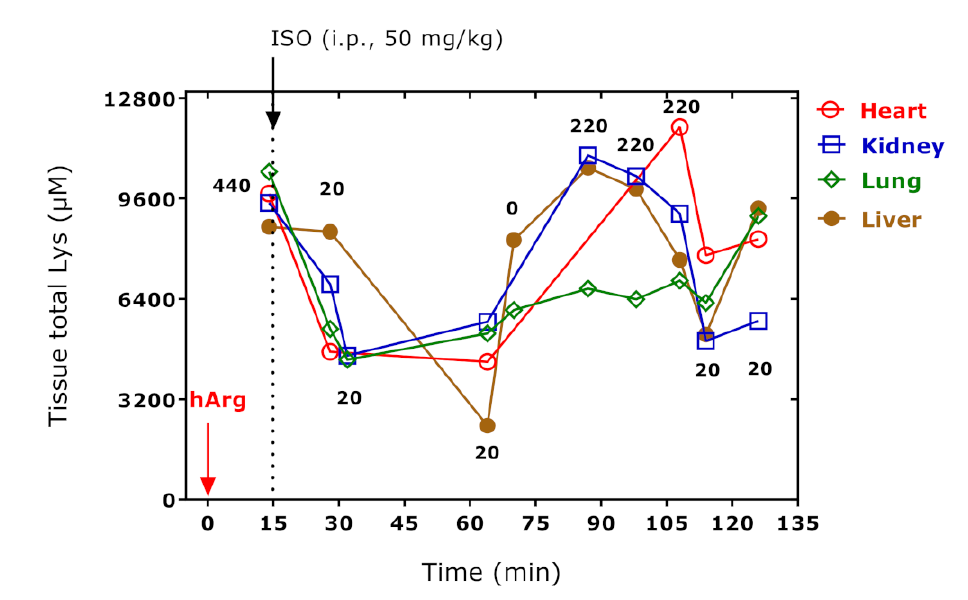
Figure 4. Total Lys concentrations in heart, kidney, lung, and liver of the study rats administered with the indicated hArg doses at t = 0 min and isoprenaline (ISO) at t = 15 min and sacrificed at the indicated time points. Arrows indicate the administration of hArg and isoprenaline. See Table